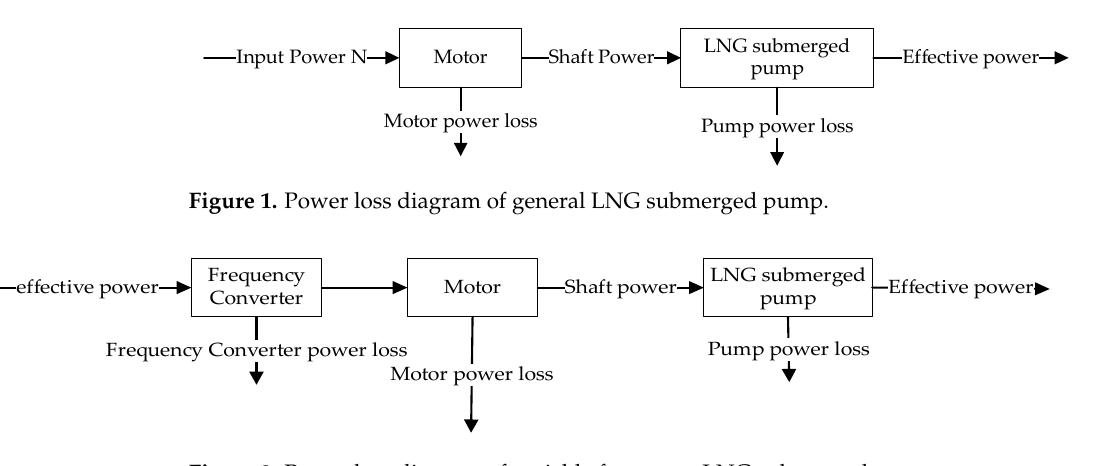
Figure 2. Power loss diagram of variable frequency LNG submerged pump.